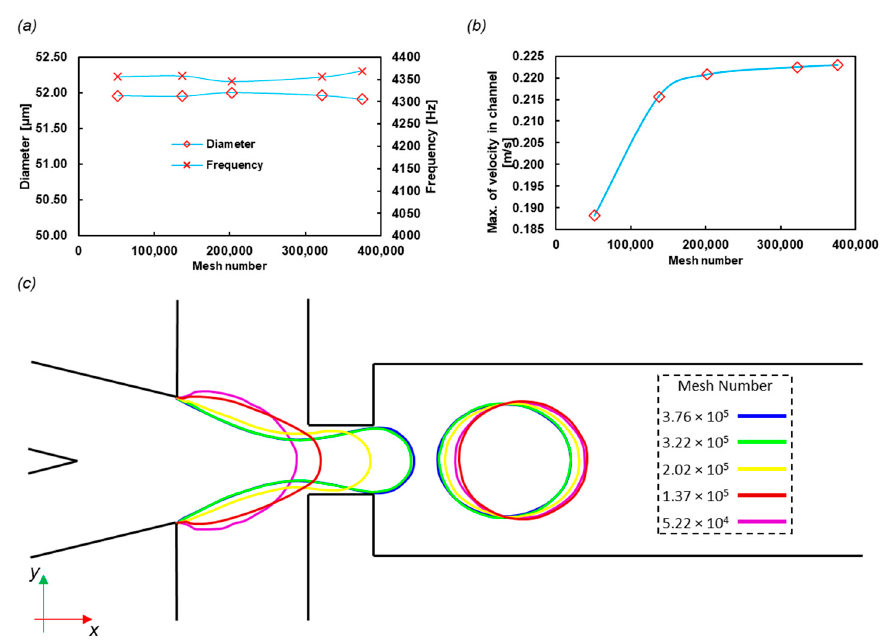
Figure 5. Grid study on ( a ) the droplet diameter and frequency and ( b ) the velocity of the center of the incoming channel. The mesh number e ff ect on the droplet diameter is not significant (less than 1%), and thus the lowest number of mesh cells needed for calculations is determined by other variables, such as the velocity field. ( c ) The W / O interface in the midplane of the domain in t = 0.0005 s with di ff erent mesh numbers, which shows the independence of the mesh.